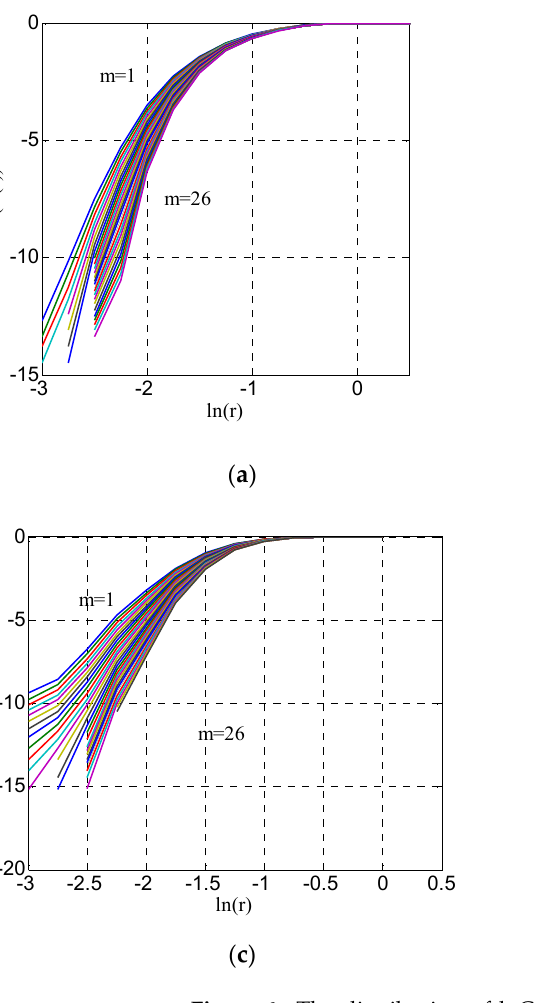
Table 2. Largest Lyapunov exponent of autonomous EDM process.